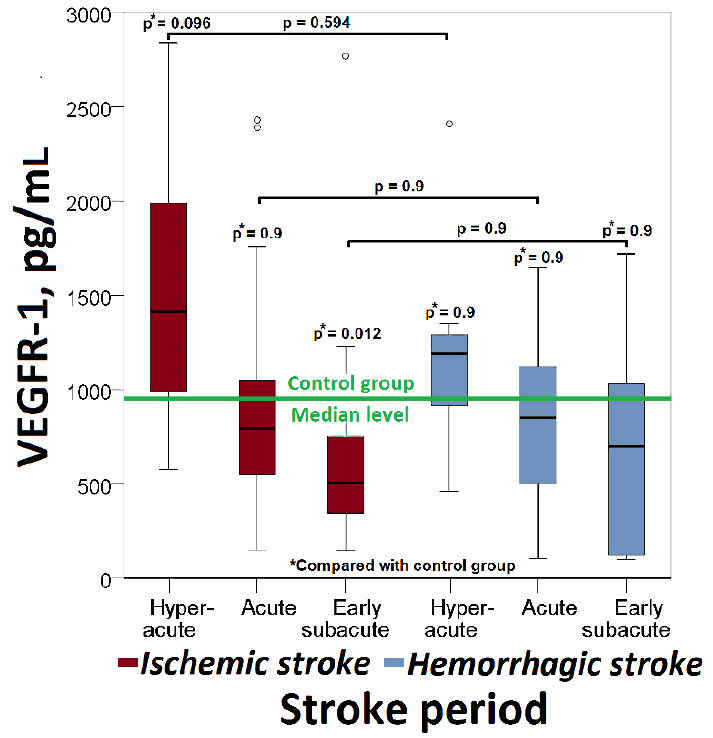
Figure 2. Changes in serum VEGFR-1 level in patients with ischemic or hemorrhagic stroke.